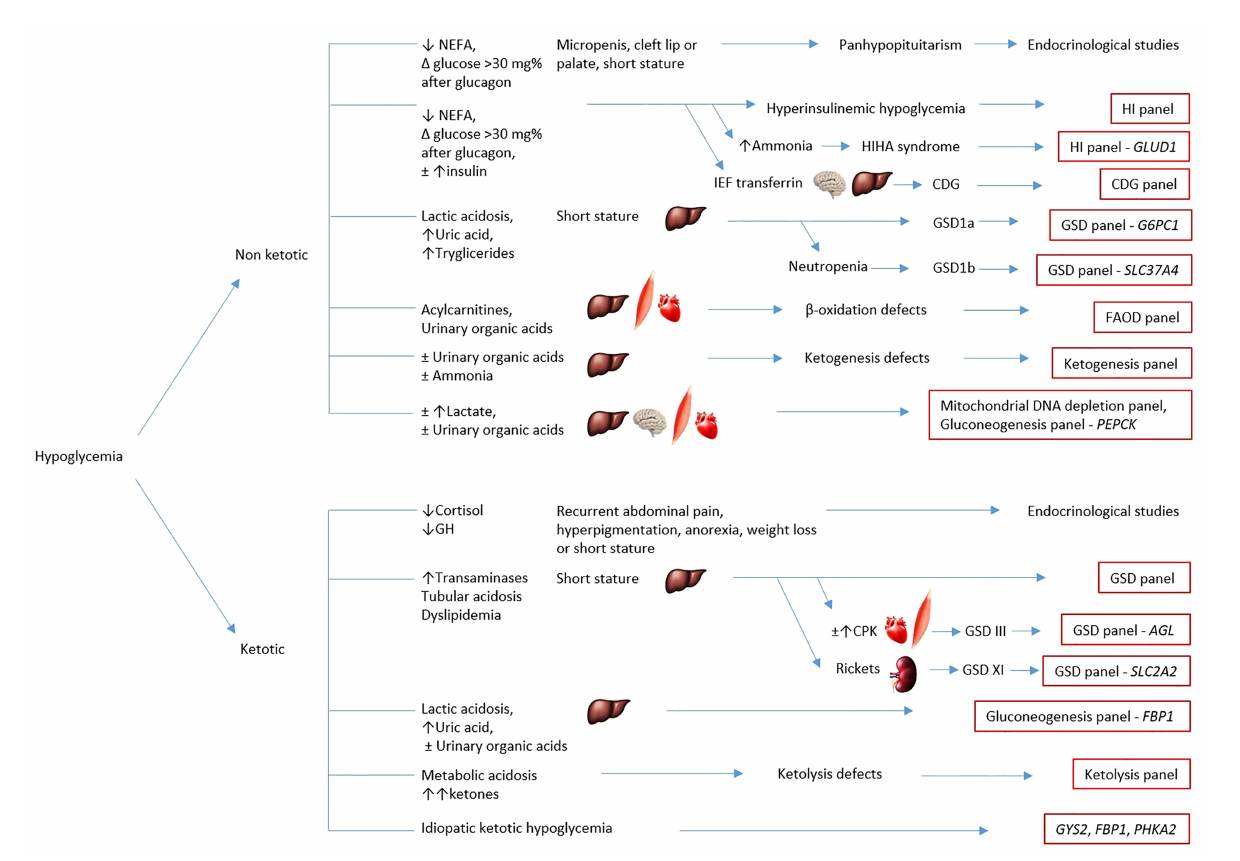
FIGURE 1 | Simpli fi ed chart of the diagnostic algorithm for hypoglycemia. The chart summarizes the main causes of hypoglycemia and classi fi es them according to clinical and biochemical characterization for targeted metabolic gene panel testing. The eventual hepatic, cardiac, muscular or neurological involvement is outlined by the corresponding anatomical pictures. HI, hyperinsulinemic hypoglycemia; HIHA syndrome, hyperinsulinism-hyperammonemia syndrome; CDG, congenital disorders of glycosylation; GSD, glycogen storage disorders; FAOD, fatty acids oxidation defects; IEF transferrin, isoelectrofocusing of